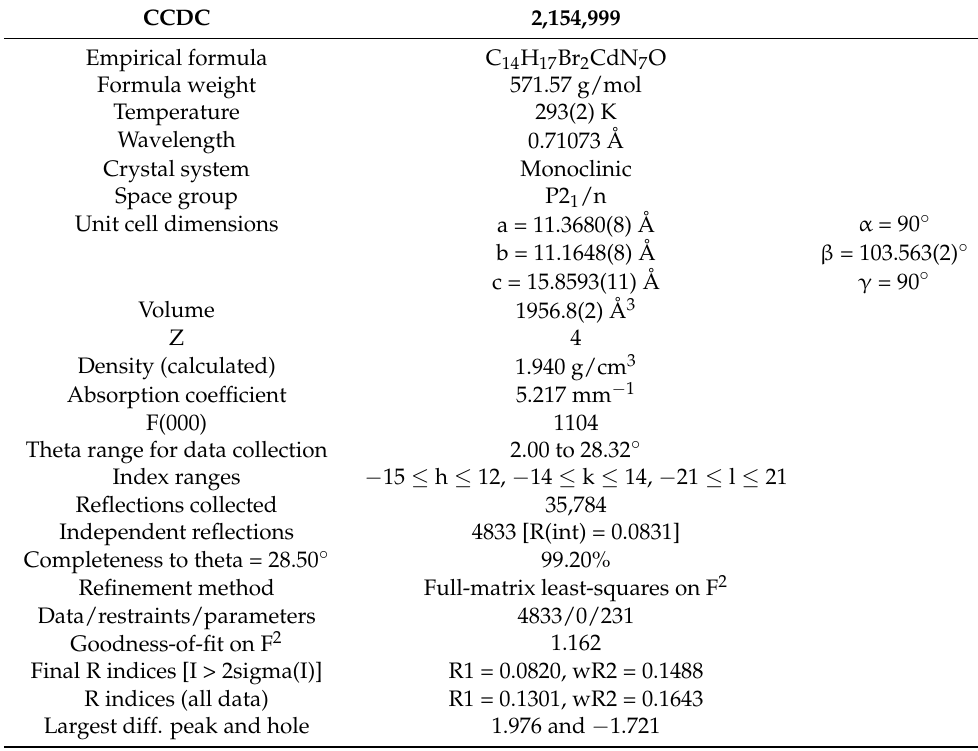
Table 1. Crystal data and refinement details of [Cd( BPMT )Br 2 ].